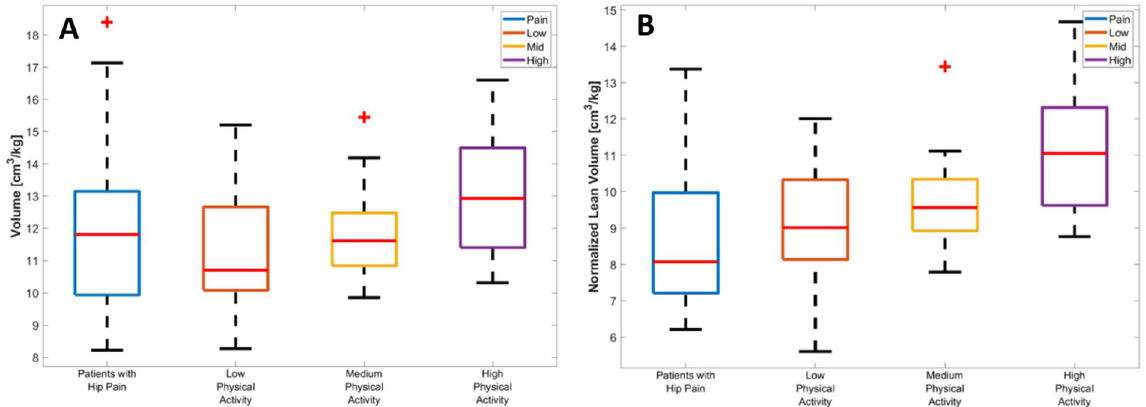
Figure 5. Volume metrics for each activity level group. Boxplots of ( A ) normalized volume and ( B ) lean normalized volume values for each group under study. On each box, the central mark is the median, the edges of the box are the 25th and 75th percentiles. The outliers are plotted individually. In A), the high activity group was significantly higher than the low activity and pain groups. In ( B ), the high activity group was significantly higher than the other three groups ( p < 0.05).